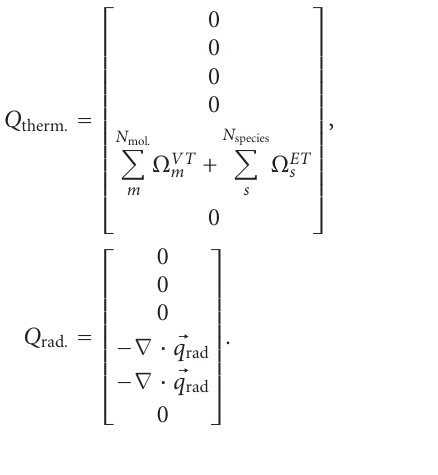
Table 2: Forward ( T f ) and backward ( T b ) rate-controlling temper- atures for bulk chemical kinetics.